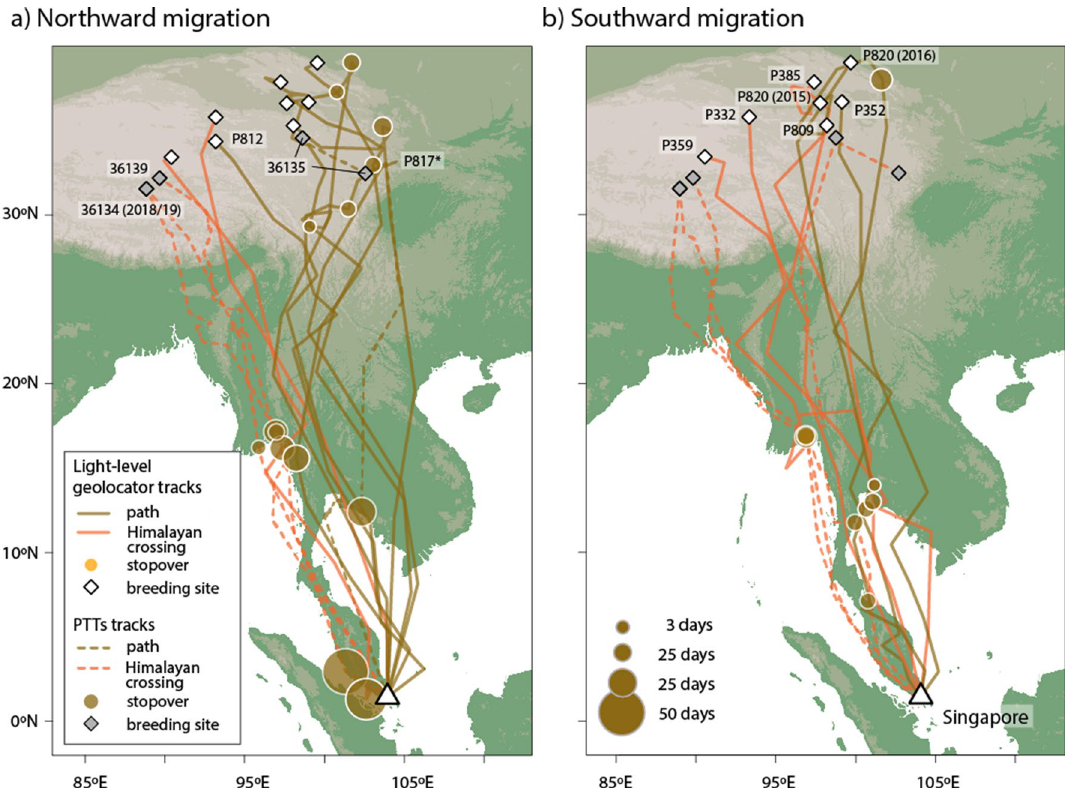
Figure 2. Migration routes of Common Redshanks based on light-level geolocation in 2015 and 2016, and PTT satellite transmitters in 2018 and 2019. Map Source: ETOPO1 1 Arc-Minute Global Relief Model dataset provided by NOAA https ://www.ngdc.noaa.gov/mgg/globa l/globa l.html.